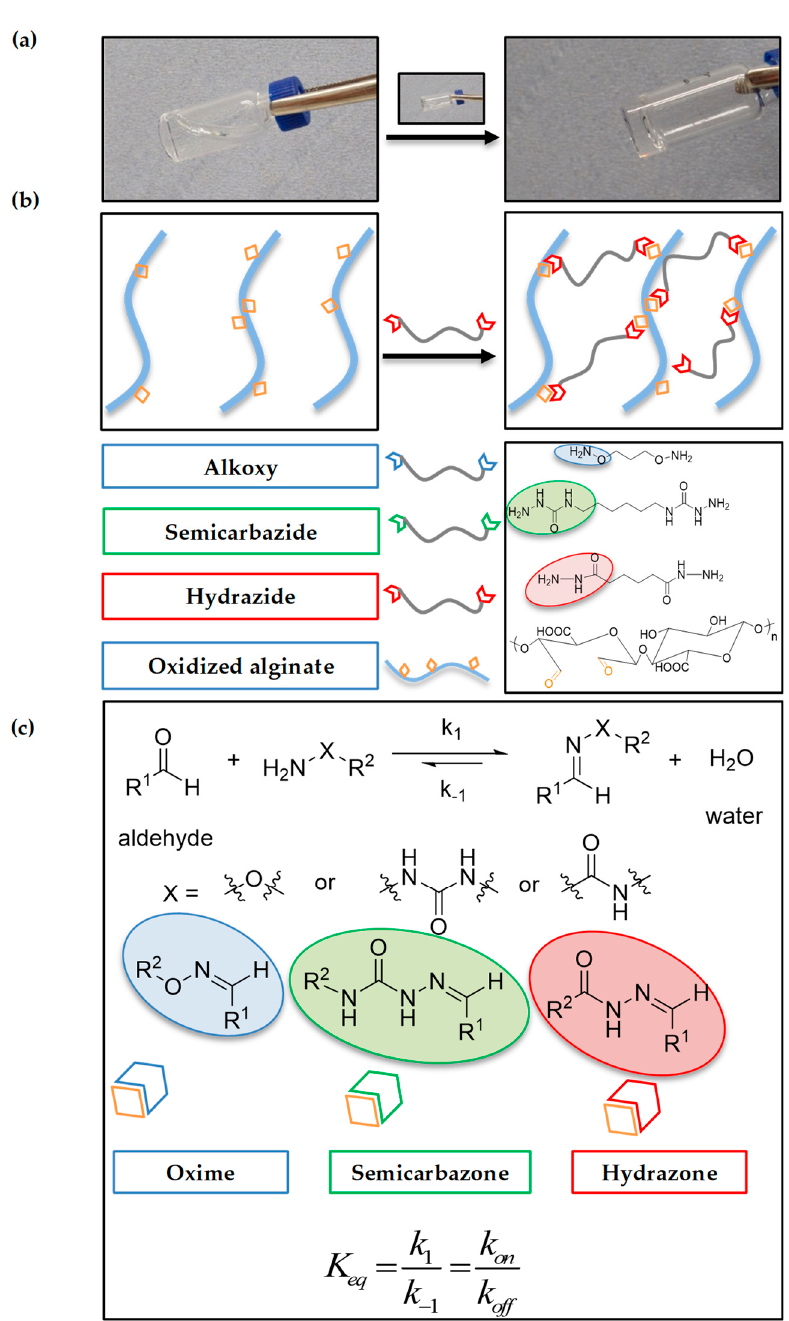
Figure 1. Scheme of hydrogel formation. ( a ) Representative gel formation for a hydrazone gel. ( b ) Schematic illustrating the crosslinking of alginate chains using dihydrazide cross-linker, the structure of oxidized alginate and the structures of cross-linkers utilized in this study. ( c ) A general reaction scheme for reversible imine type bonds formation and chemical structures of oxime, semicarbazone and hydrazones.